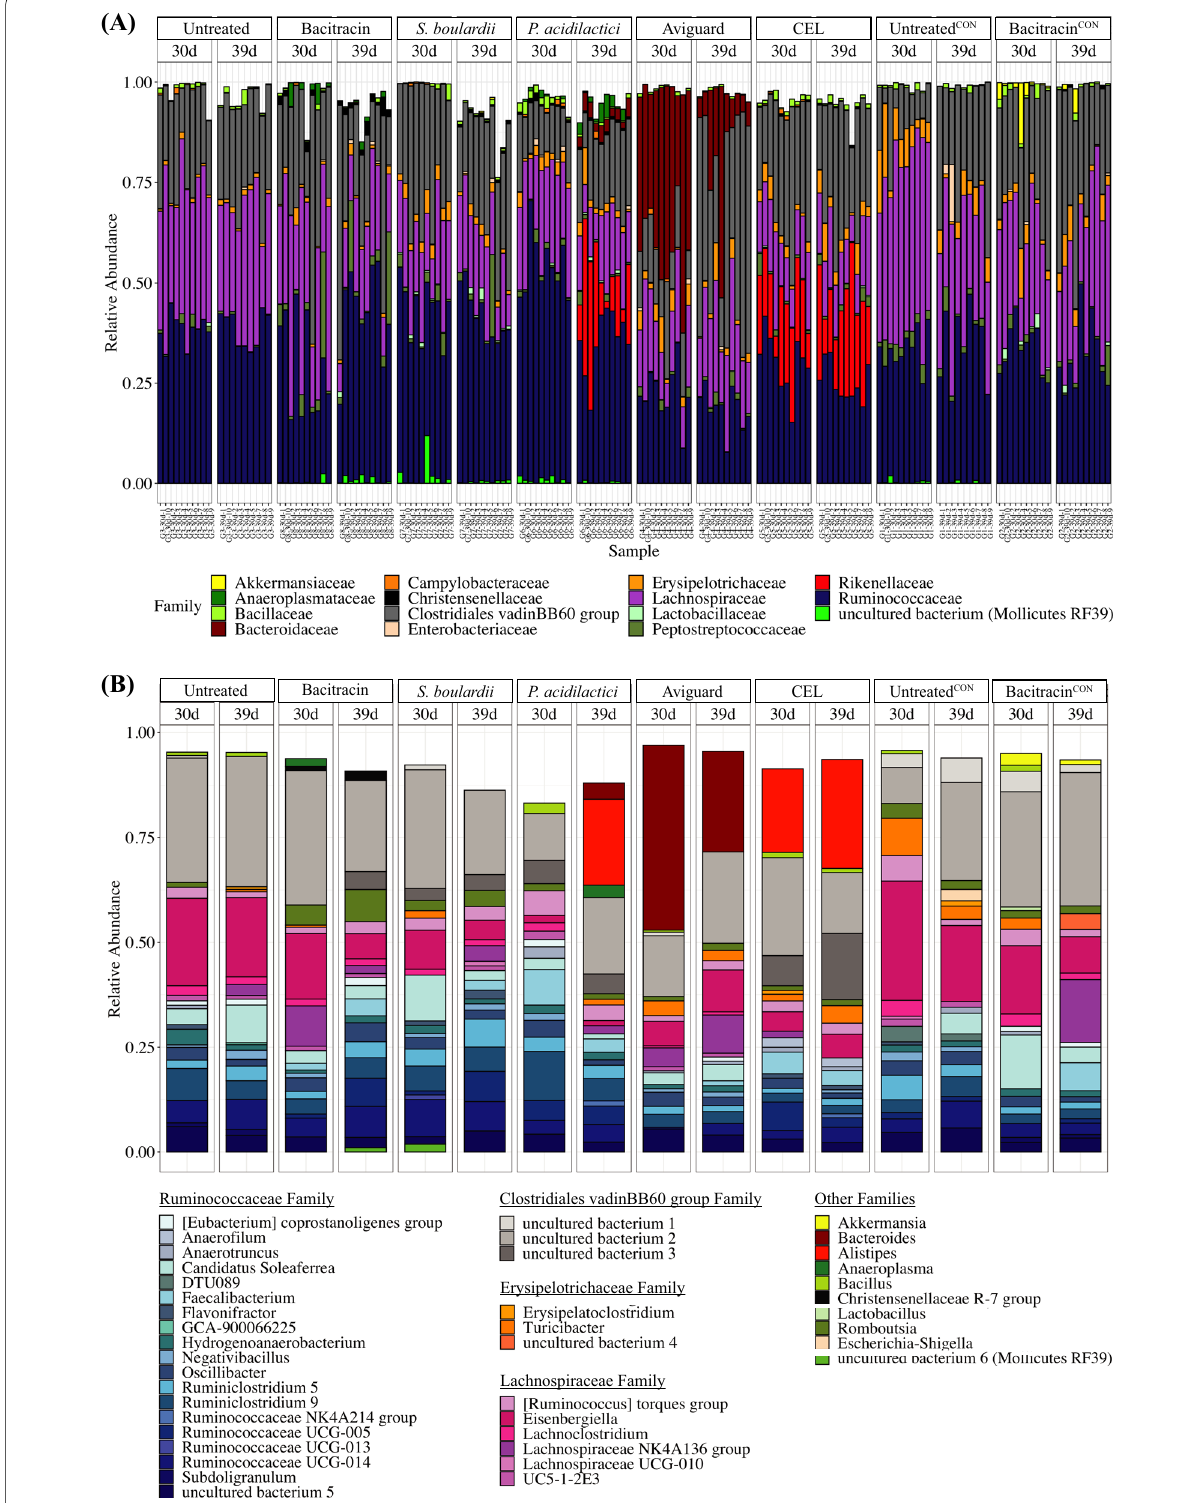
Fig. 3 Microbial community composition of chicken cecal content. A Stacked bar plots representing relative abundances of the top 15 families in all samples, grouped by treatment and age. Legend lists taxonomic families in order of appearance B Stacked bar plots representing relative abundances of the top 20 genera in each treatment and